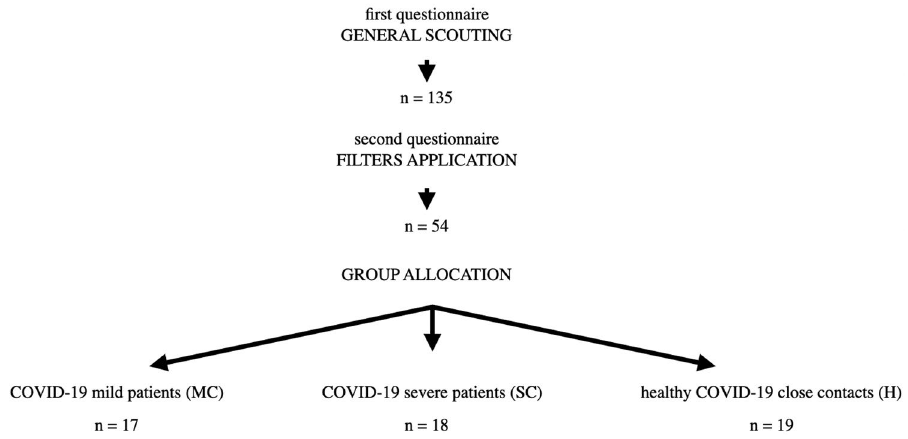
Figure 1. Target population selection